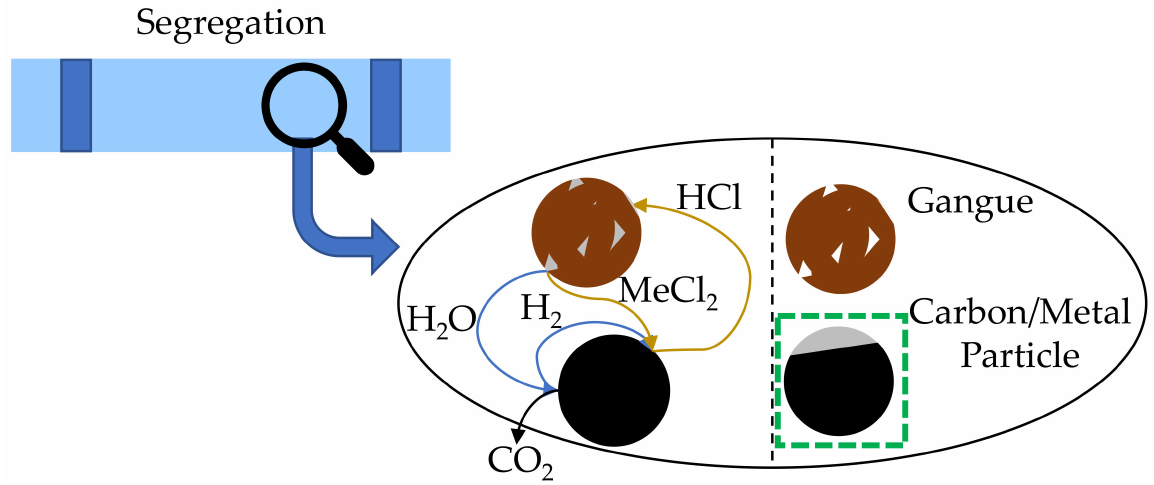
Figure 9. Schematic segregation